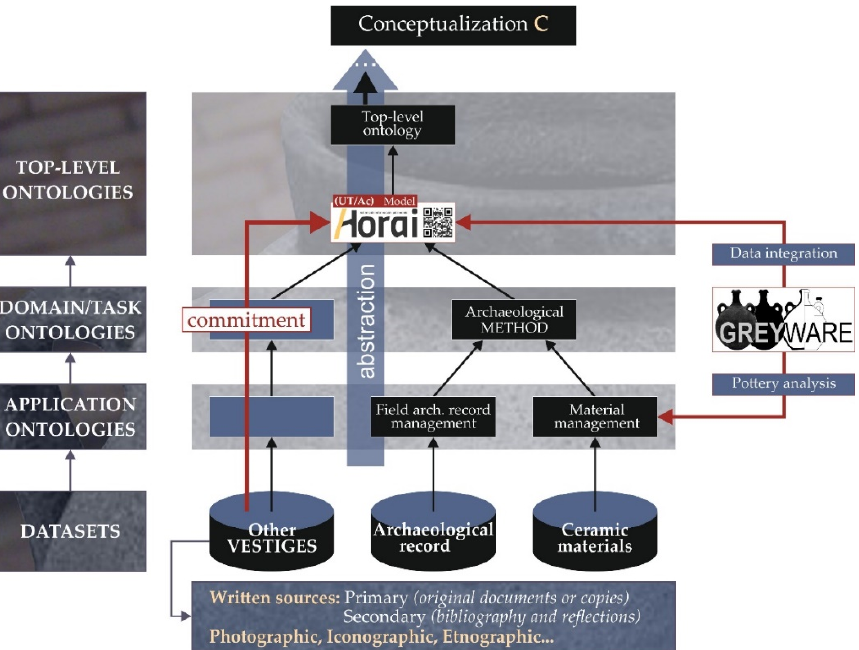
Figure 1. Graphic representation of the G REYWARE ontological commitment to the H ORAI UT/Ac model as a top-level ontology.